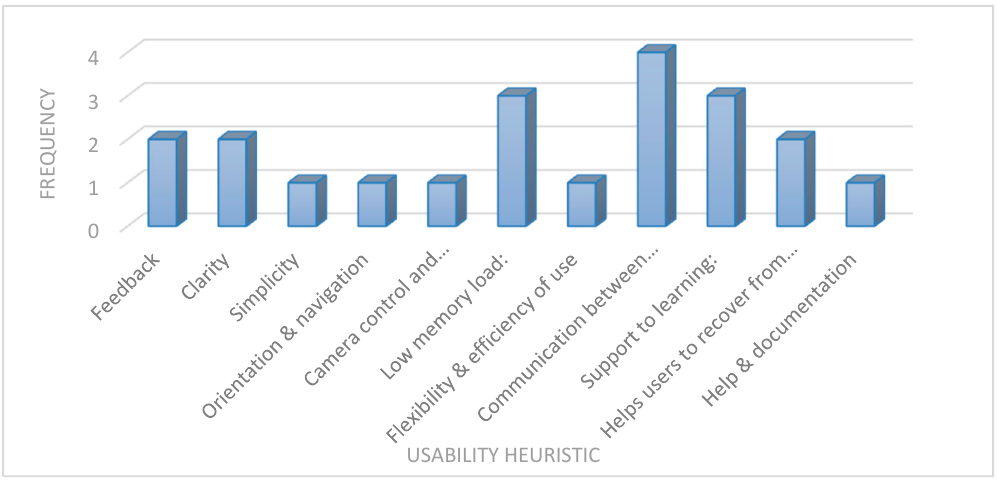
Figure 8. Categorisation of heuristic violations for the REVERIE ECA.